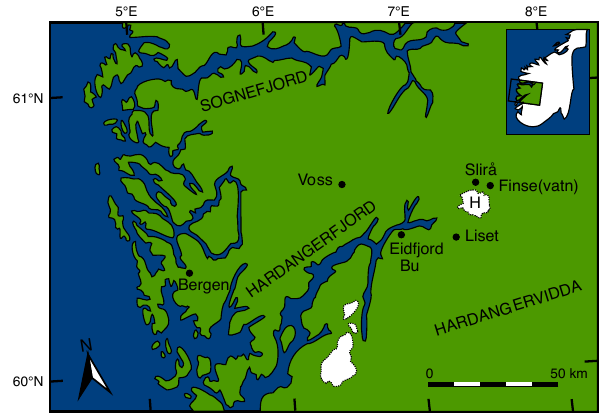
Fig. 1. Map showing the location of Hardangerjøkulen (H) in south- ern Norway and the locations of the synoptic weather stations from which records are used in this